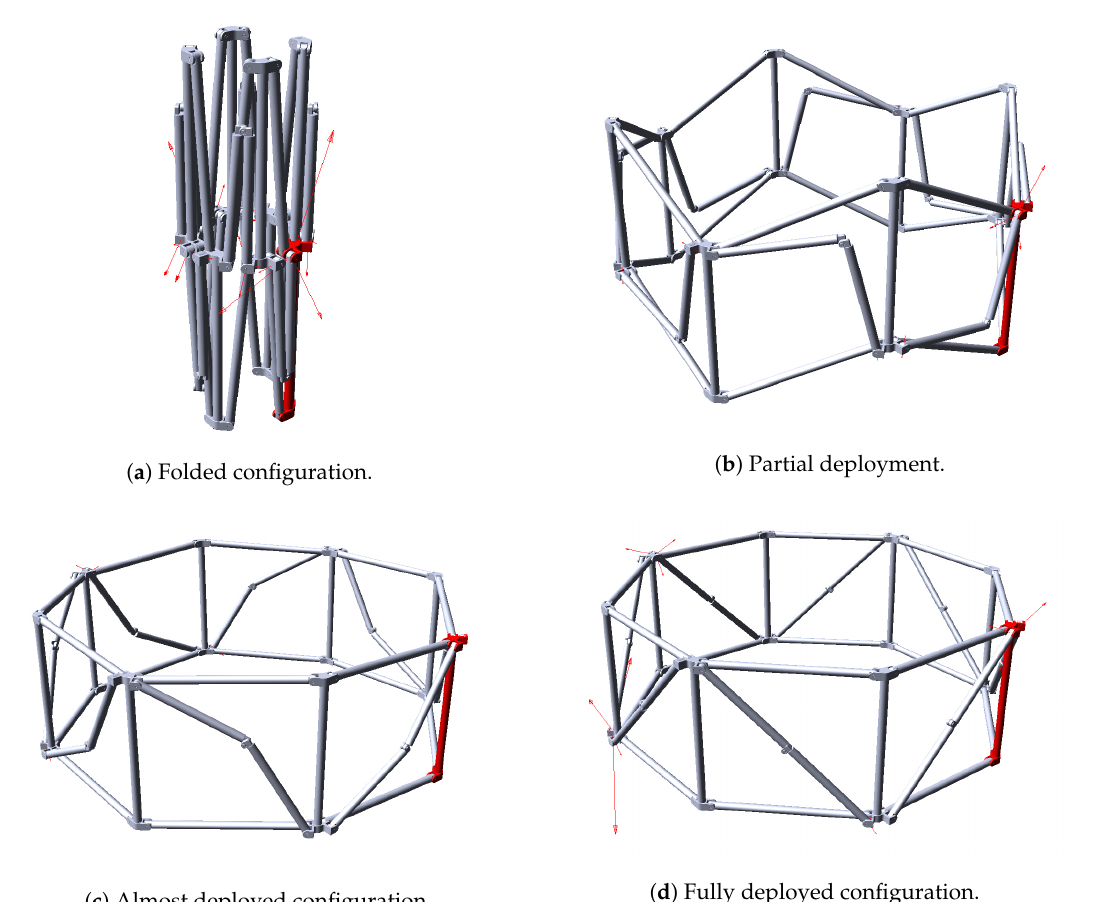
Figure 9. Damping torque vs. rotation speed for different dampers present on the market (Catalogue ACE c (cid:13) Rotary Dampers FDT/FDN-47 to 70).